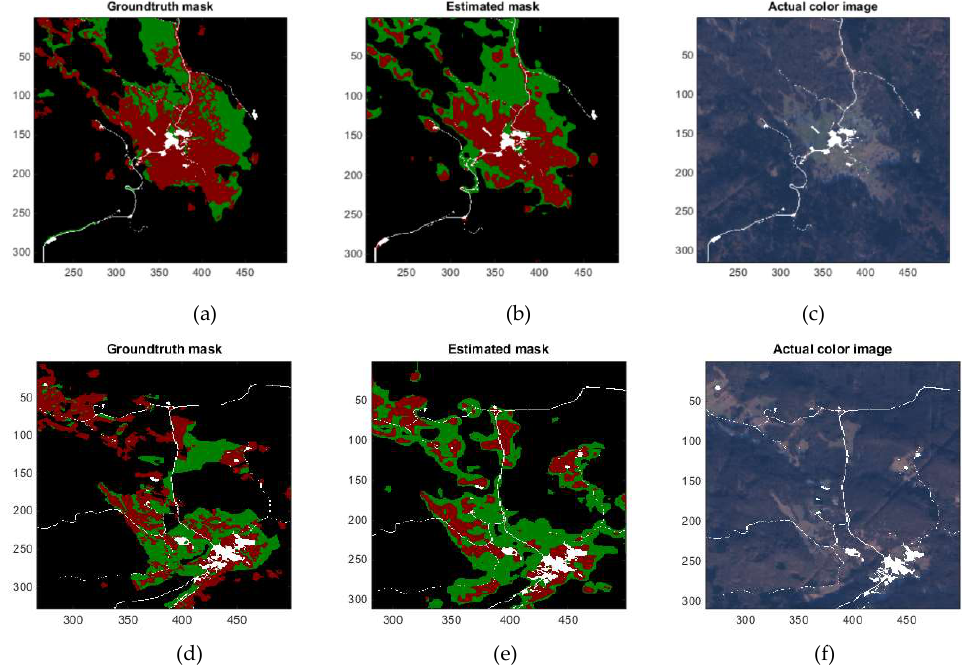
Figure 4. Demonstrations of vegetation class annotations from two samples in Slovenia test set (black color corresponds to forest, red color corresponds to grassland, green color corresponds to shrub land, and white color corresponds to ignore class in land cover map annotations). ( a ) Groundtruth land cover map for test image no: 15; ( b ) estimated land cover map for test image no: 15; ( c ) color image for test image no: 15; ( d ) groundtruth land cover map for test image no: 19; ( e ) estimated land cover map for test image no: 19; ( f ) color image for test image no: 19.